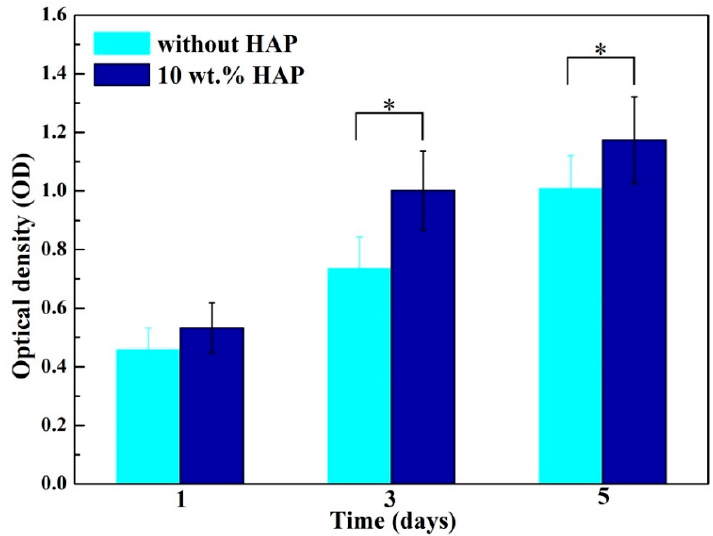
Figure 9. MTT assay of MG-63 cells cultured on PEEK/PGA scaffolds and PEEK/PGA-10 wt % HAP scaffolds (* p < 0.05).